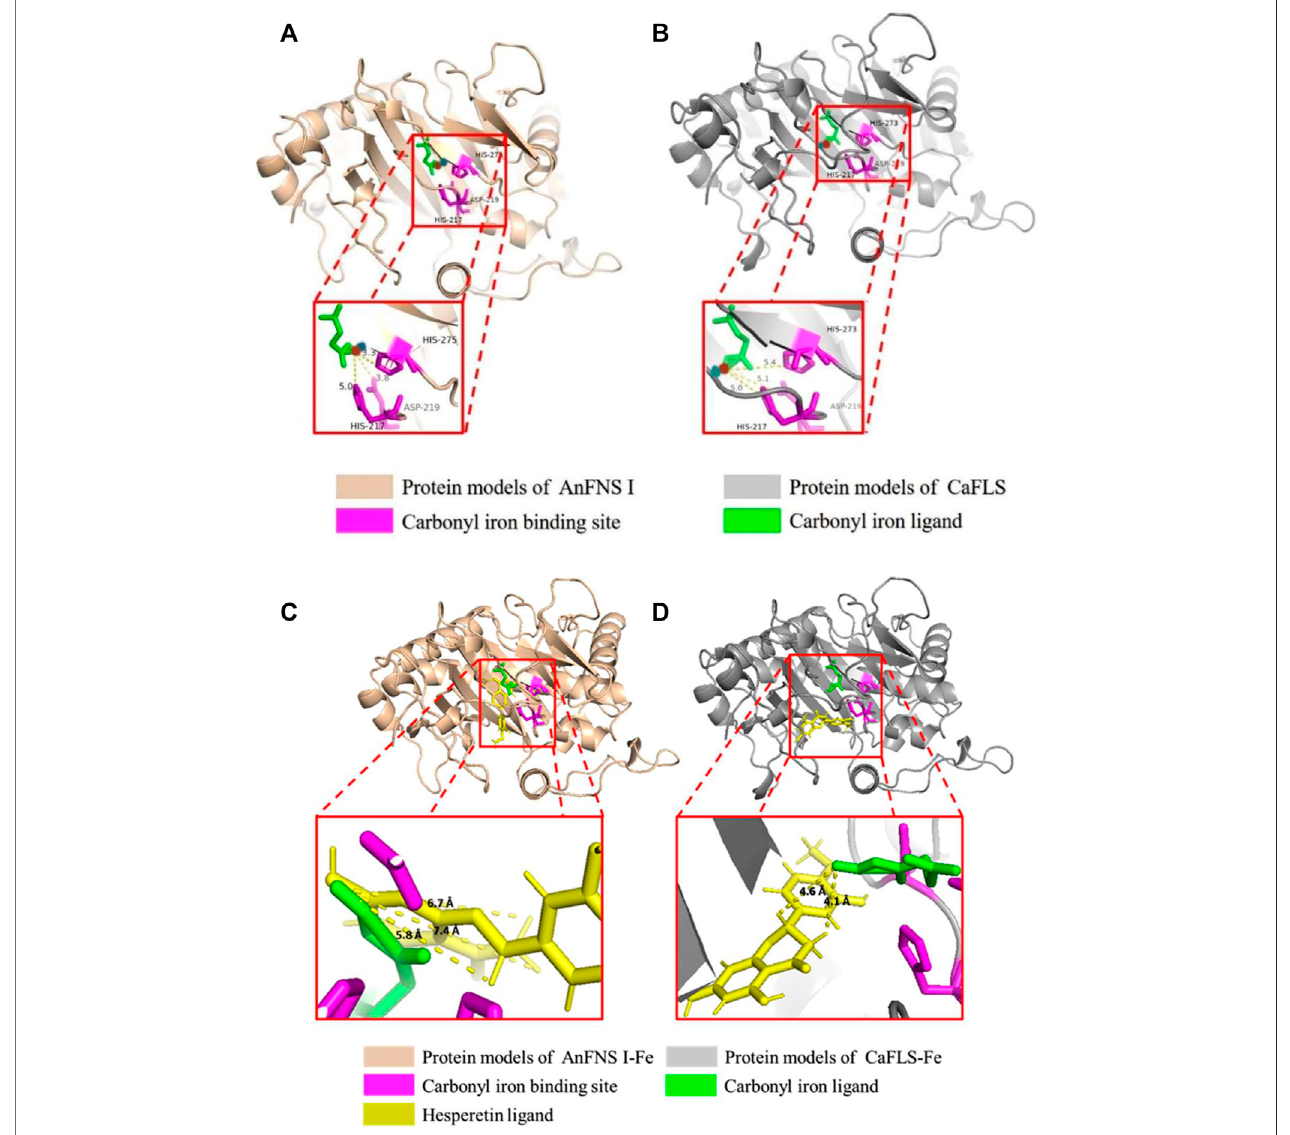
FIGURE5| BindingconformationofAnFNSI/CaFLSwithCarbonylironandHesperetin.Note: (A) BindingconformationofAnFNSIwithCarbonyliron. (B) Binding conformationofCaFLS withCarbonyliron (Bluedots represent oxygenatoms and reddots represent iron atoms). (C) Binding conformation ofAnFNS IwithHesperetin. (D) Binding conformation of CaFLS with